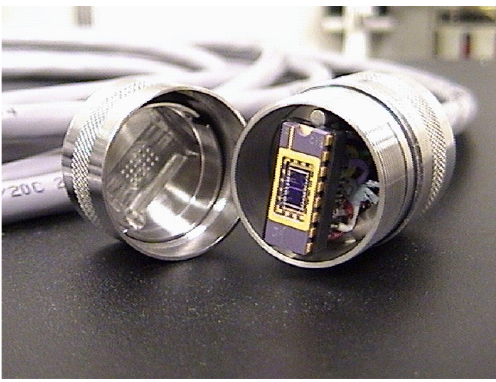
Figure 4. Chemiresistor sensor package disassembled, exposing the 16-pin dual-in-line package and chemiresistor